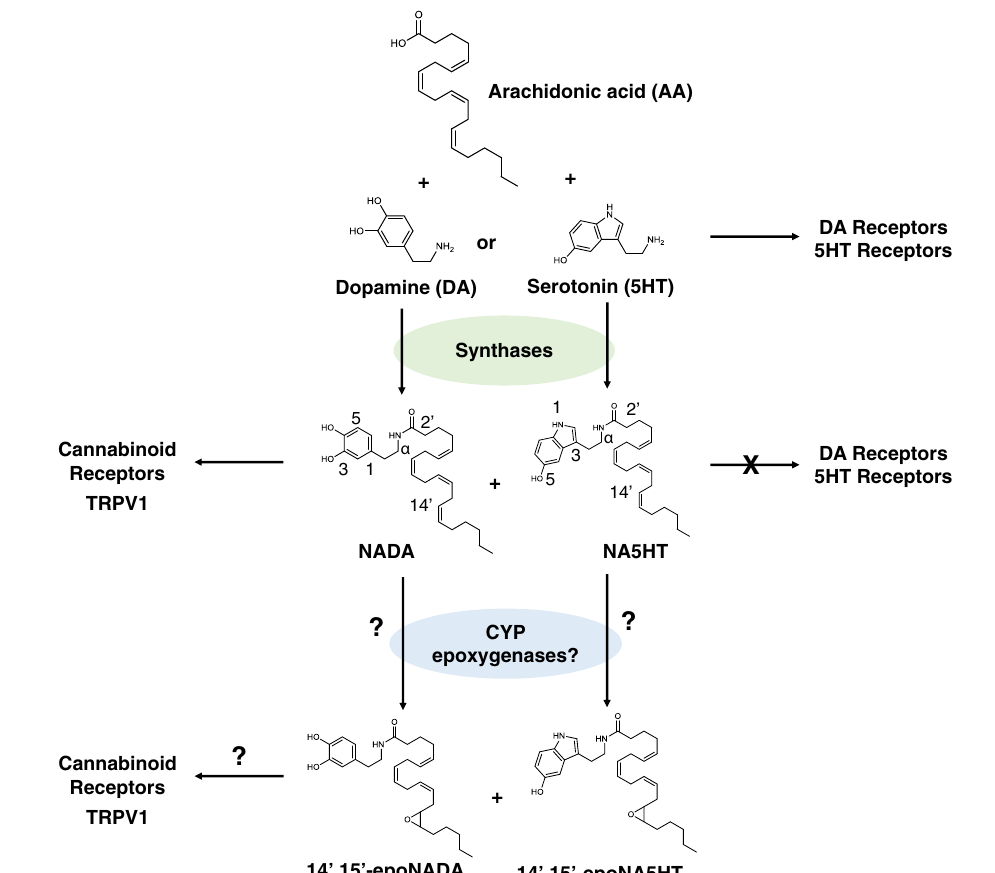
Fig. 1 The endovanilloid (eVD) pathway and structures of 14 ’ ,15 ’ -epoNADA and 14 ’ ,15 ’ -epoNA5HT. NADA and NA5HT are synthesized by fatty acid amid hydrolase and other unidenti fi ed enzymes by the conjugation of arachidonic acid (AA) with dopamine (DA) or serotonin (5HT), respectively. NADA and NA5HT are known modulators of cannabinoid receptors and TRPV1; however, they do not activate DA or 5HT receptors. Herein, we study the epoxidation of NADA and NA5HT by CYP epoxygenases and test their effects on cannabinoid receptors and